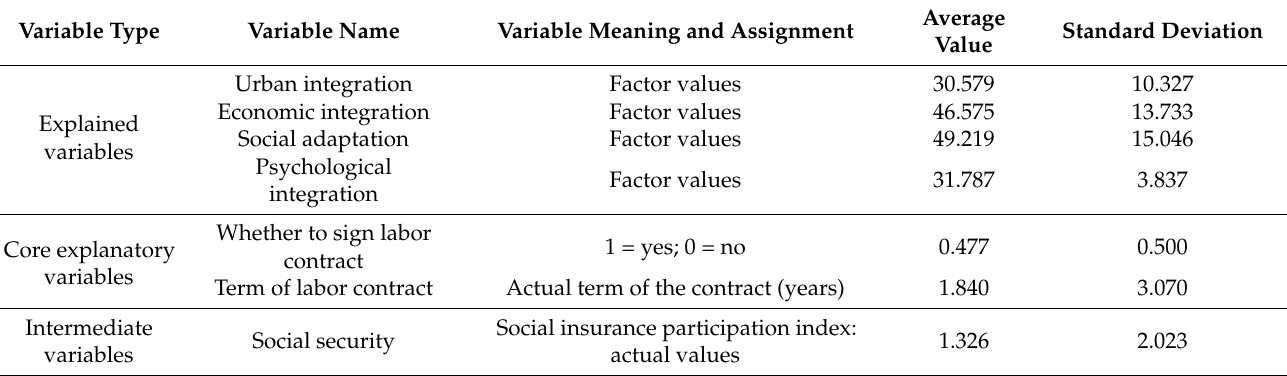
Table 2. Meaning of variables and descriptive